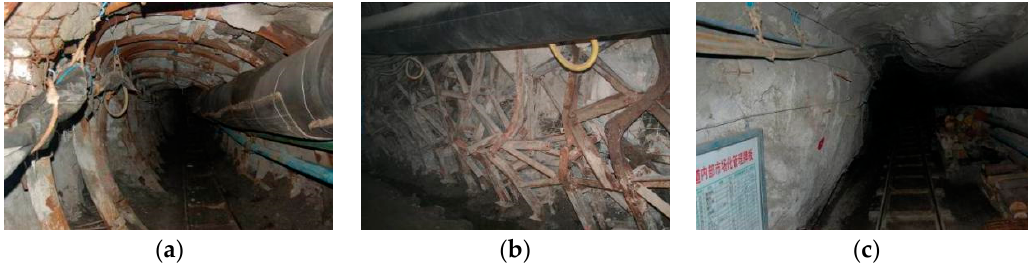
Figure 1. Argillaceous roadway site with different support. ( a ) U-shaped steel support in Figure Zhuxianzhuang Mine; ( b ) truss in Liuhai Mine; ( c ) cable and grout in Liuhai Mine. U-shaped steel support and truss cannot effectively restrain the deformation of surrounding rock mass.